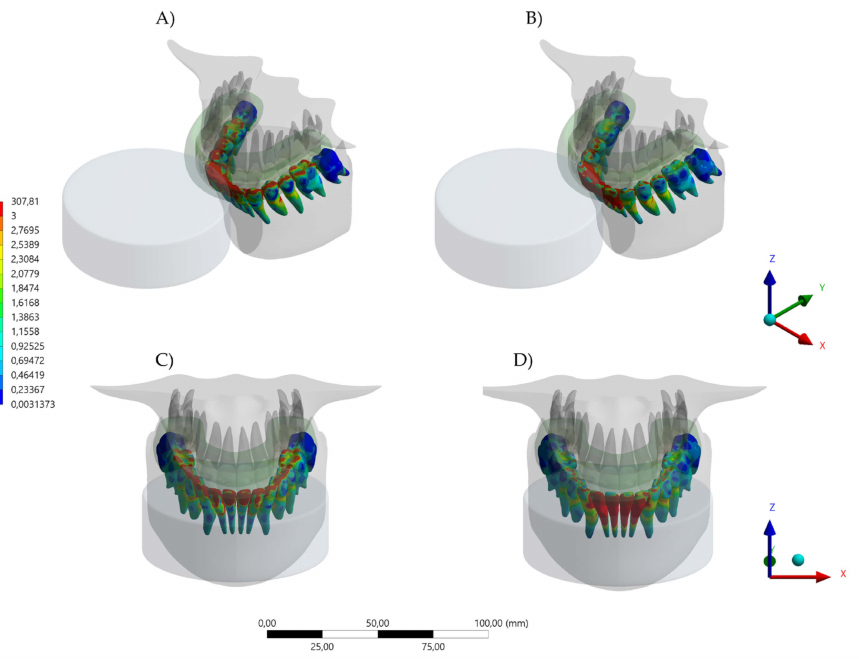
Figure 7. Von Mises Stress result in lower teeth. ( A ) Isometric view of the lower teeth stresss with the conventional design and ( B ) isometric view of the lower teeth stresss with the hybrid (HMG) design. ( C ) Buccal view of the lower teeth stresss with the conventional design and ( D ) buccal view of the lower teeth stresss with the hybrid (HMG)